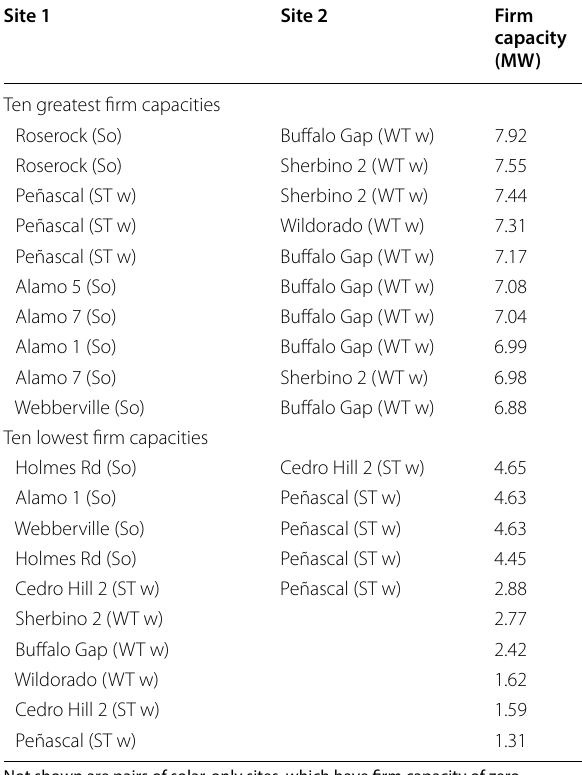
Not shown are pairs of solar-only sites, which have firm capacity of